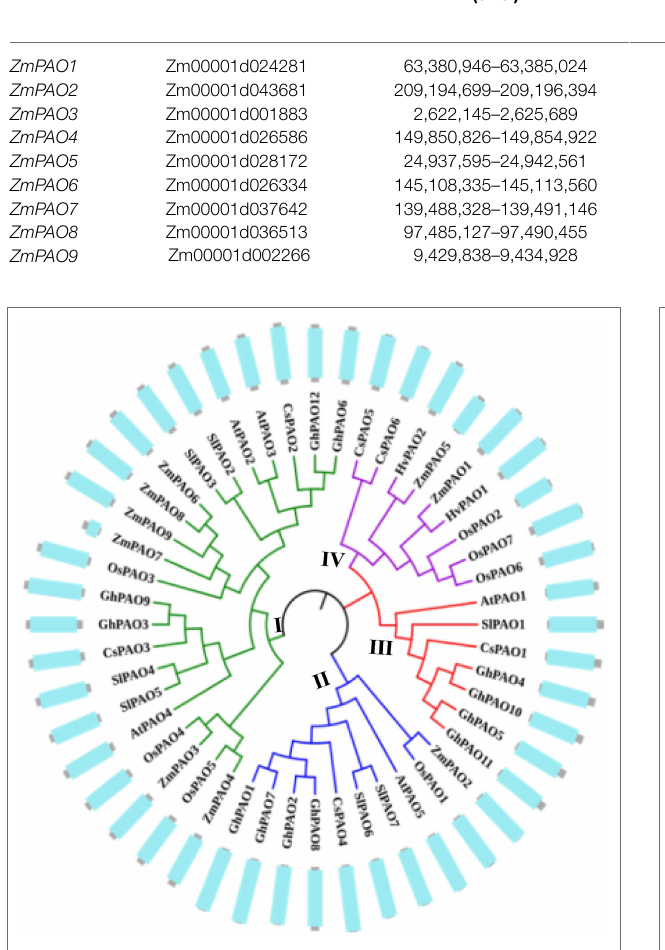
FIGURE 1 | Phylogenetic analysis among the polyamine oxidase (PAO) proteins from seven representative species. The accession numbers of the genes were listed in Supplementary Table 1 . The colored branch of the tree indicated that the total PAO proteins were classed into four groups, and nine ZmPAO proteins were classed into three groups according to the amino acid sequence alignment by MEGA 7.0 software with the Neighbor-joining method. The conserved amine-oxidase domains of these proteins were exhibited in the outer ring. Gray represents the length of the amino acid sequence and blue represents the sequence of the conserved amine-oxidase domain.